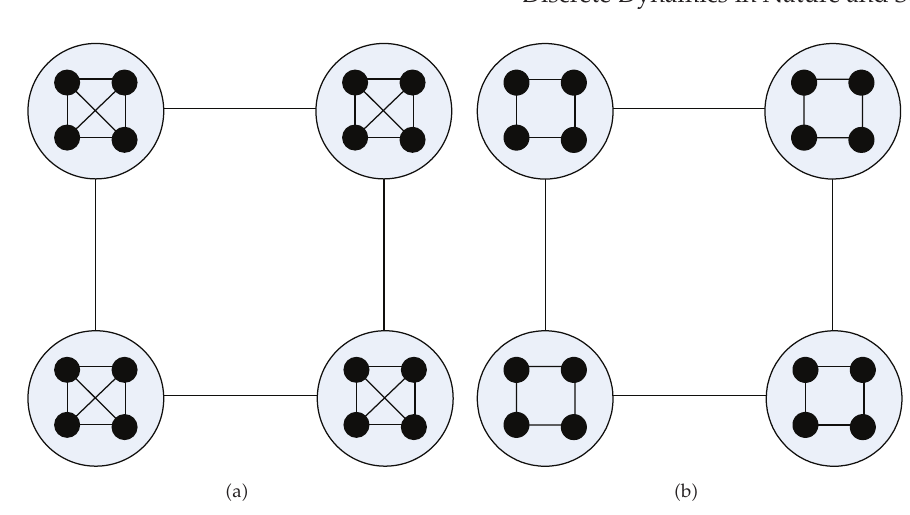
Figure 1: Hierarchical topologies of the